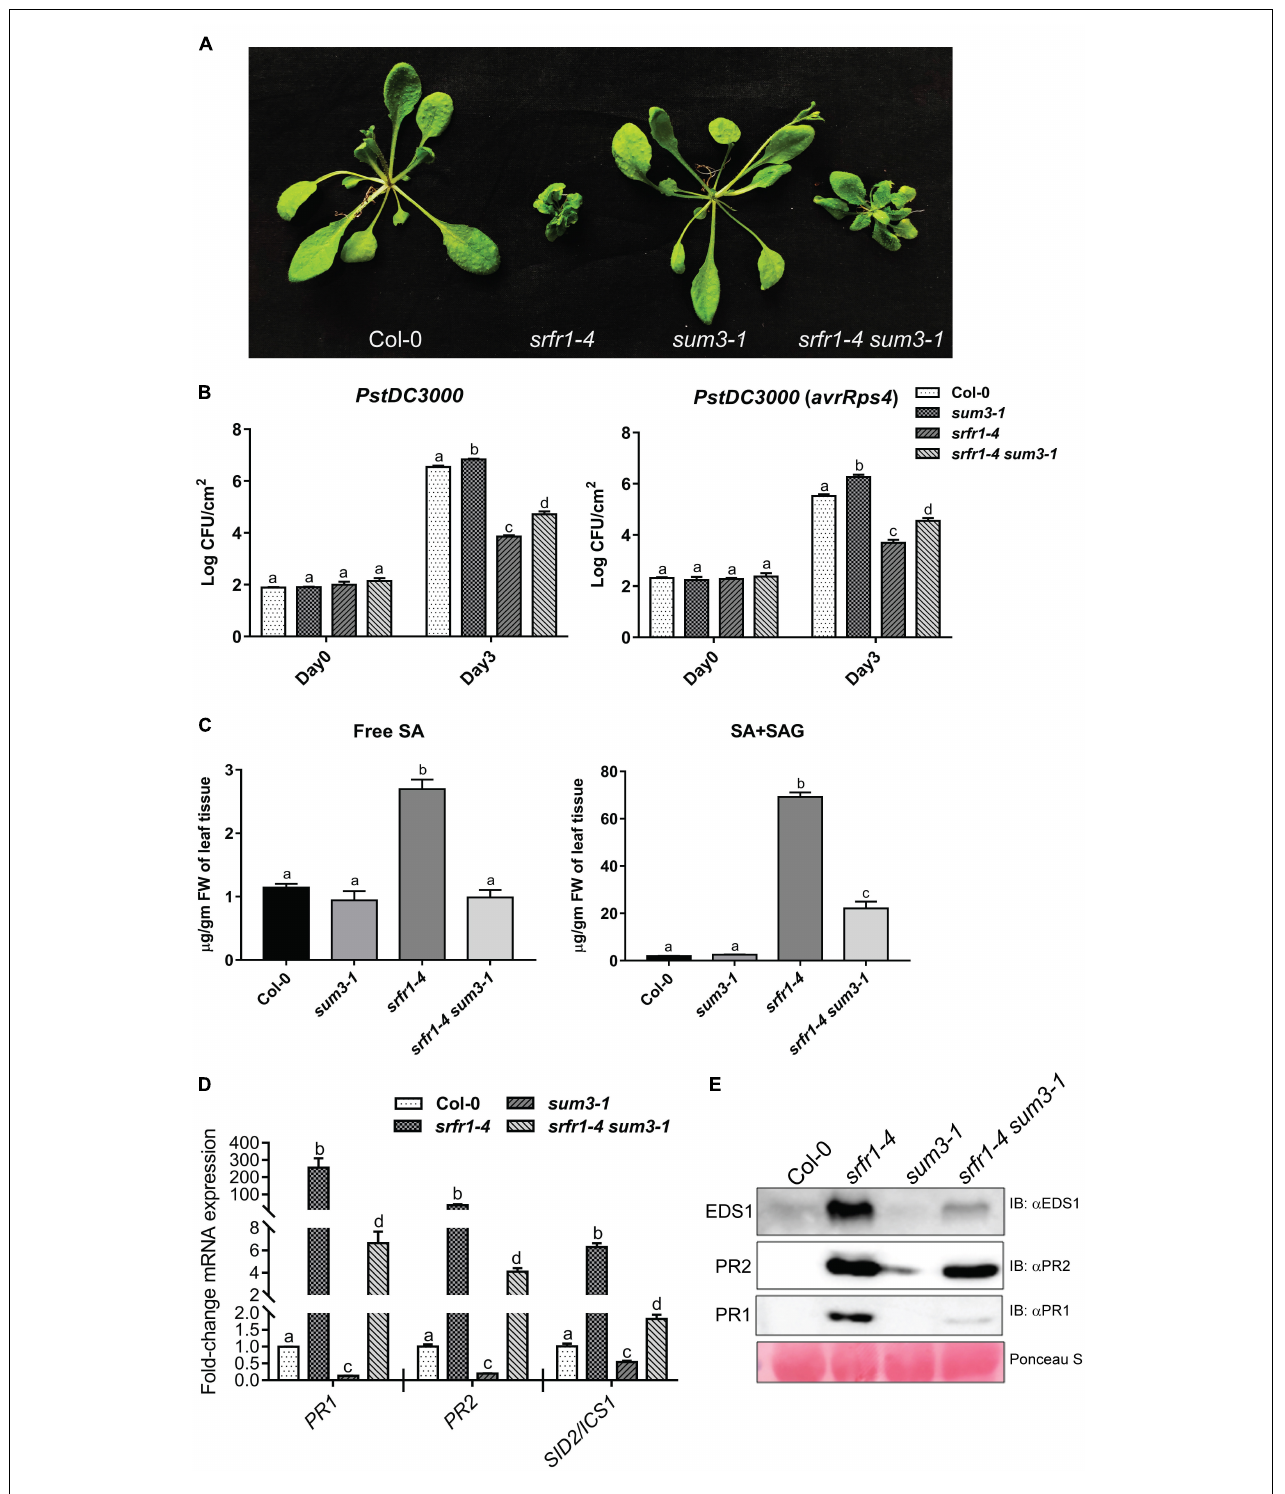
FIGURE 7 | Enhanced defenses in srfr1-4 are partially SUM3 -dependent. (A) Growth phenotypes of 3- to 4-week-old plants of indicated genotypes. (B) Bacterial growth measurements with virulent PstDC3000 or avirulent PstDC3000 ( avrRps4 ) strains; (C) free and total SA levels; (D) transcript abundance of PR1 , PR2 , or SID2/ICS1 ; and (E) protein levels of EDS1, PR1, or PR2 in Col-0, srfr1-4 , sum3-1 , or srfr1-4 sum3-1 plants. Growth of bacterial strains at day 0 or day 3 post-challenge is shown. Statistical significance in transcript expression levels is via post hoc Tukey’s test ( p < 0.05) and marked by different letters ( n = 3).